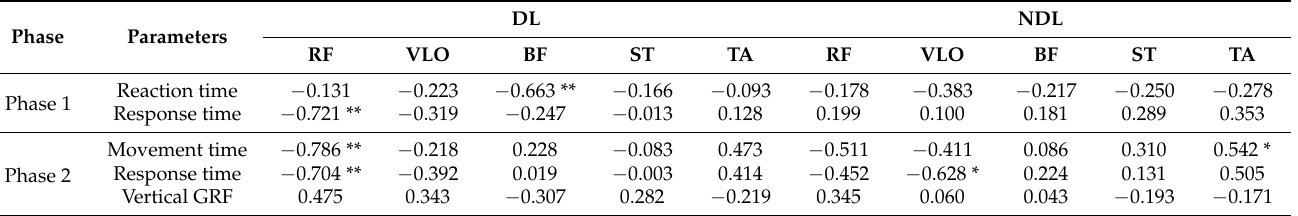
Table 4. Correlation between muscle activation of dominant leg and non-dominant leg and reaction time, movement time, response time, and vertical